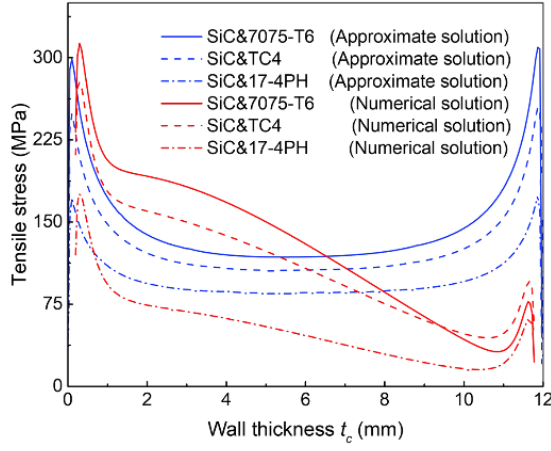
Figure 8. Linearized distribution of tensile stress on the contact surface along the wall thickness (three groups of SiC ceramic pressure housings).